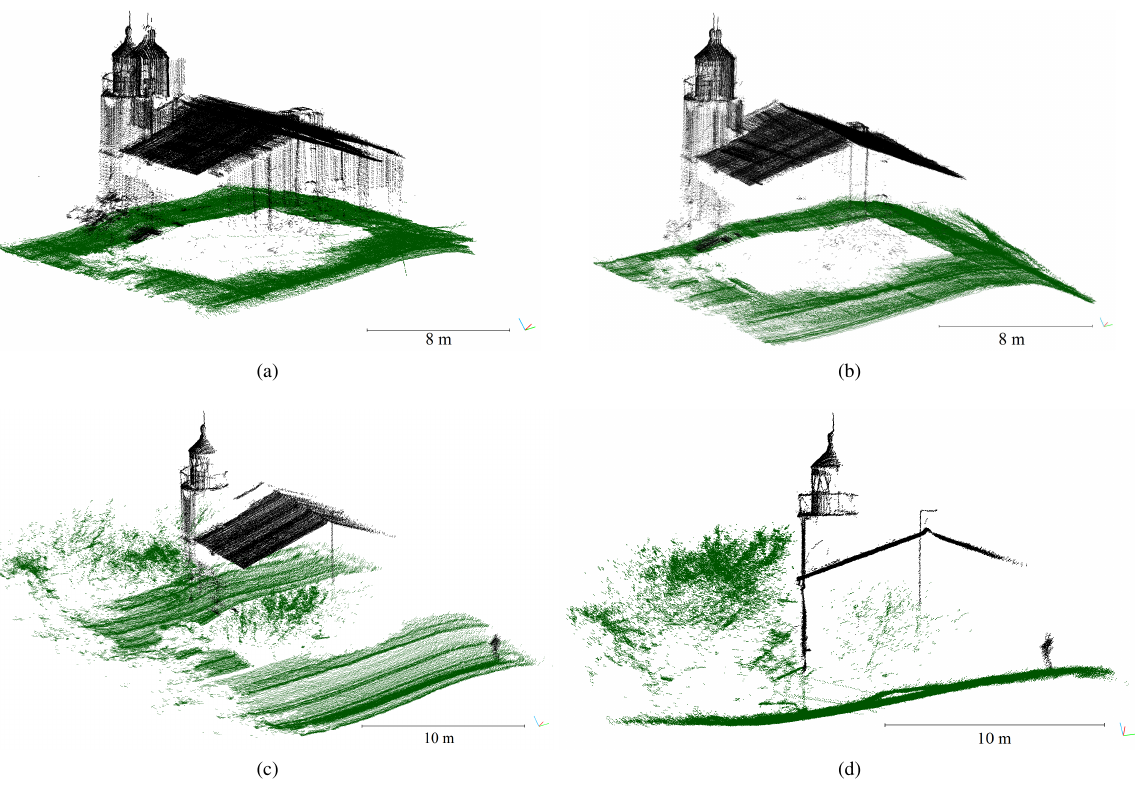
Figure 6: 3D point cloud of the lighthouse on basis of data from laser scanning range finder mounted on an UAV. (a) Unaligned point cloud with large lateral discrepancies. (b) Aligned point cloud. (c) The separate strips (in this case strip 2) shows the lighthouse with